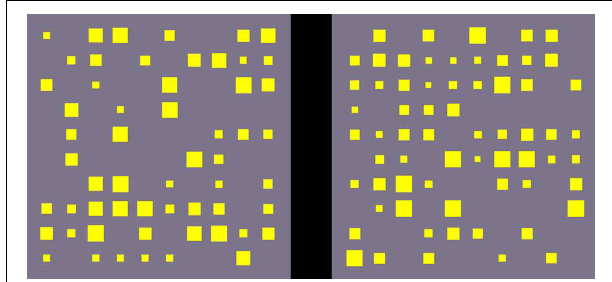
FIGURE 1 | Example item of the magnitude comparison task (small